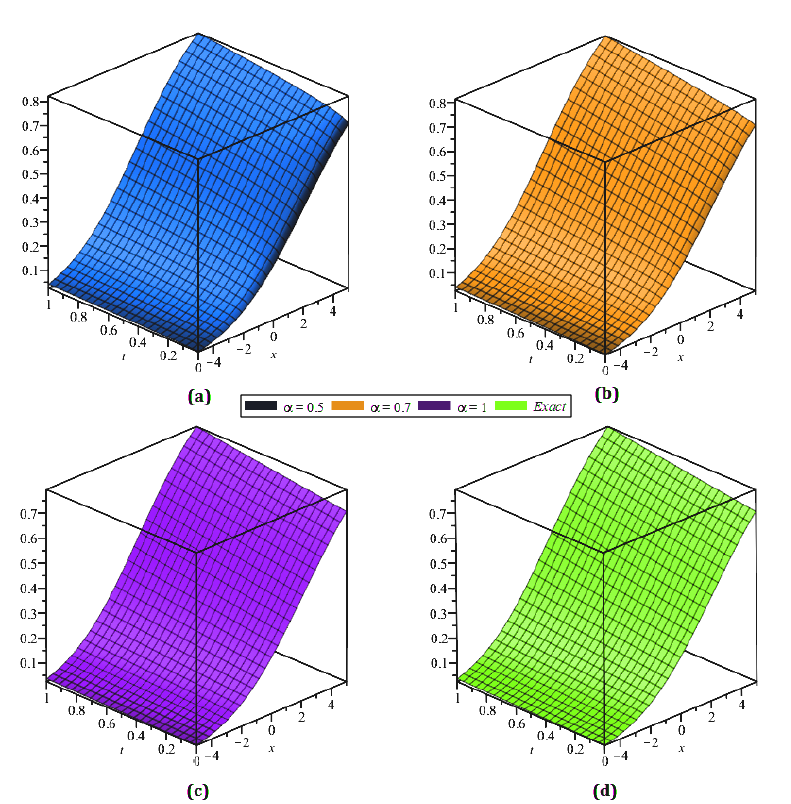
Figure 2. The actual and analytical results for u ( ϕ , τ ) at k = 2 Example 1.